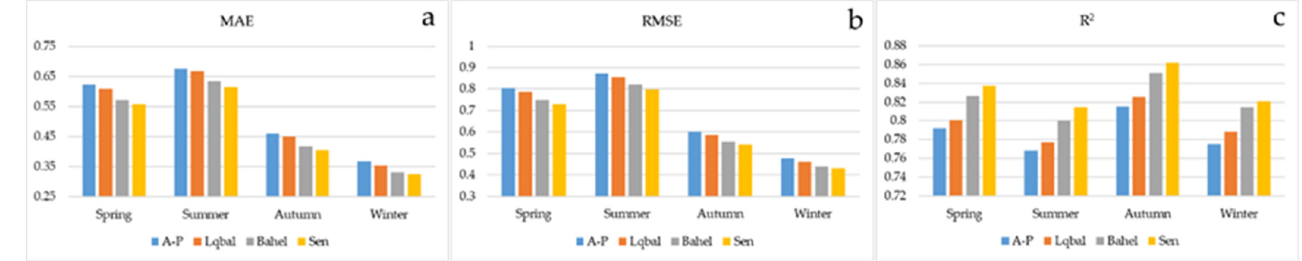
Figure 5. Error-checking results ( MAE ( a ), RMSE ( b ) and R 2 ( c )) for the four models in different seasons.